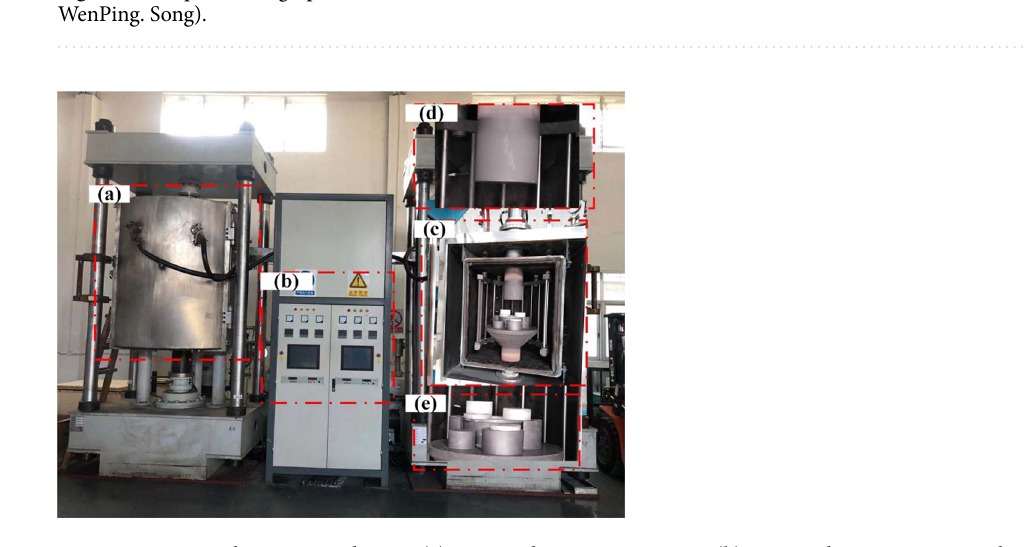
Figure 3. Vacuum hot pressing devices. ( a ) Vacuum hot pressing system; ( b ) Vacuum hot pressing control system; ( c ) Vacuum hot pressing furnace; ( d ) The punch; ( e ) Gaskets and indenters (Visio 2021, Prof. WenPing.